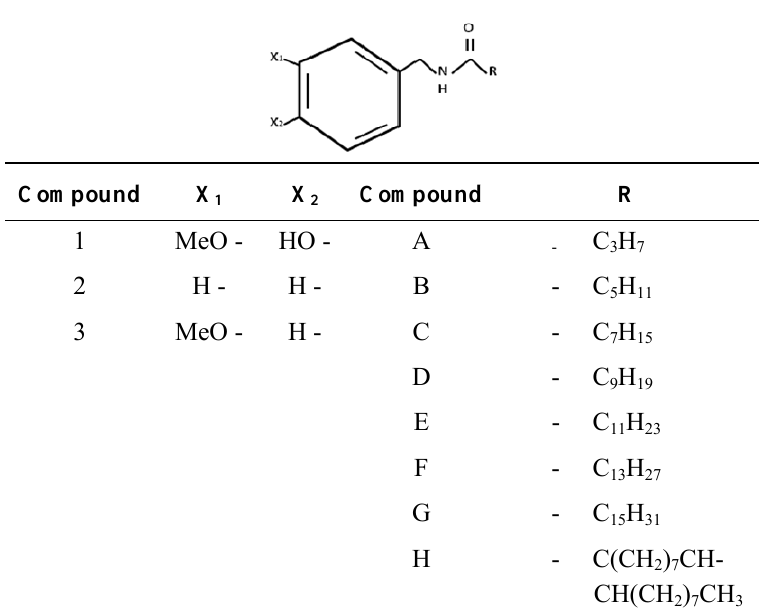
Figure 3 . Synthesis of capsaicin analogues using different amines and donors as substrates